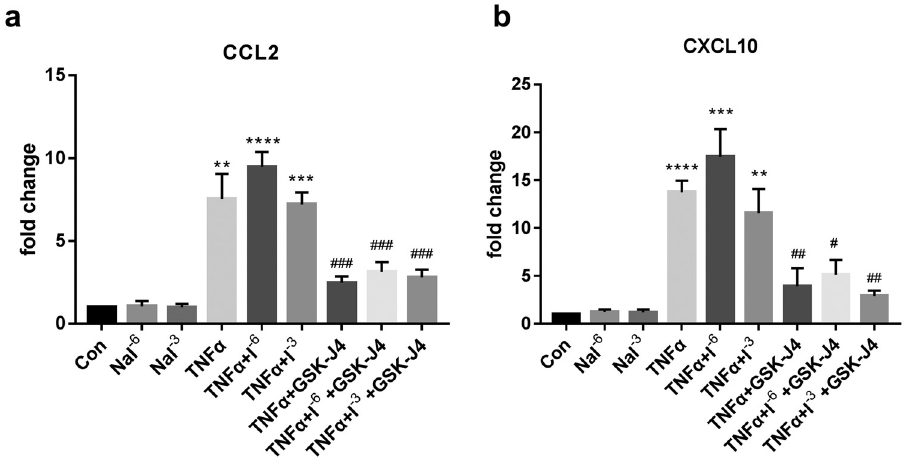
Figure 3: The expression of CCL2 and CXCL10 in thyroid cells with stimuli. Con: control. NaI − 6 /I − 6 : 10 − 6 mol/L NaI; NaI − 3 /I − 3 : 1 × 10 − 3 mol/L NaI. ( a ) mRNA expression of CCL2 with the stimulation of TNF - α , iodine, and GSK - J4. ( b ) mRNA expression of CXCL10 with the stimulation of TNF - α , iodine, and GSK - J4. ** P < 0.01, *** P < 0.001, **** P < 0.0001 vs control group; # P < 0.05, ## P < 0.01, ### P < 0.001 vs TNF - α stimulation without GSK - J4.